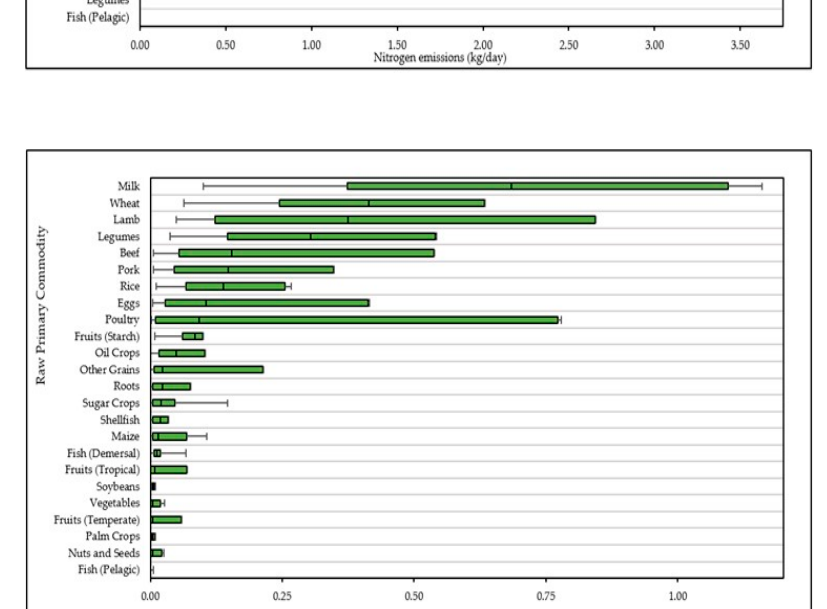
Figure 4. The contribution of foods to ( a ) cropland, ( b ) nitrogen, and ( c ) phosphorous use in Irish adults. Values shown as median, interquartile range (IQR) with 95% confidence intervals shown. Highest median contribution to each factor shown.